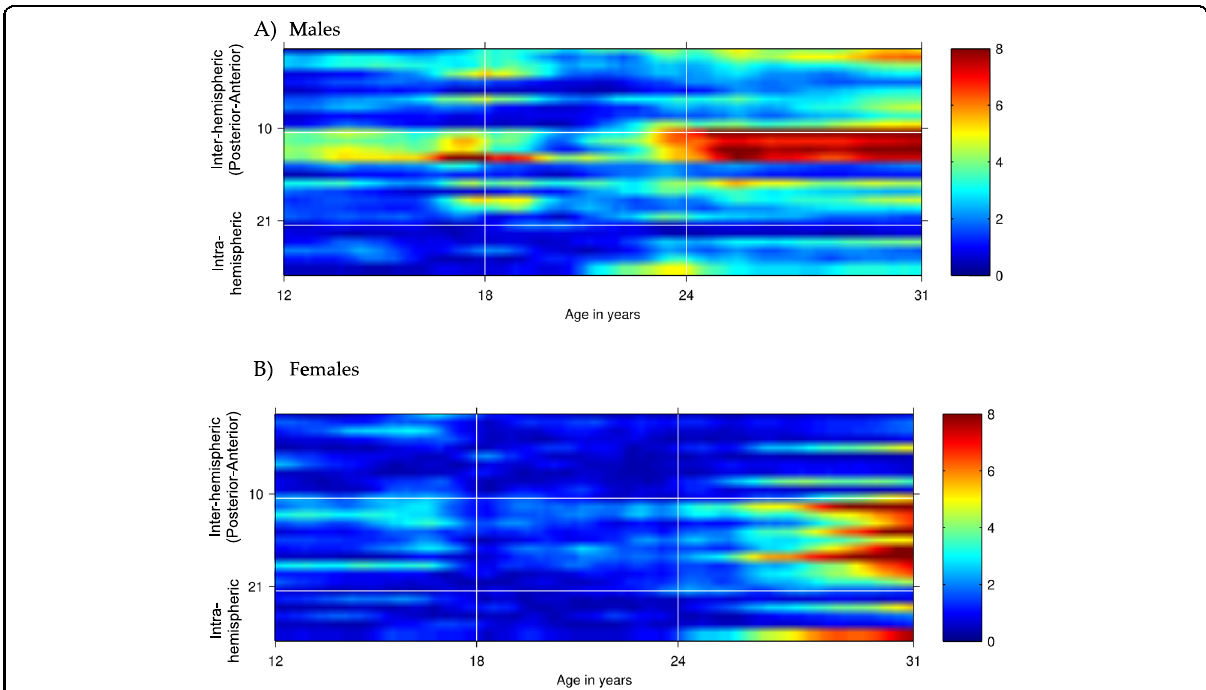
Fig. 4 Association of depression PRS with interhemispheric and intrahemispheric high-alpha EEG coherence networks in males (A) and females (B) from ages 12 – 31. Age is represented on the x -axis and coherences are represented on the y -axis, with numbering 1 – 27 corresponding to coherences between bipolar electrode pairs illustrated in Fig. 1. Regional divisions are marked with horizontal white grid lines: 1 – 10 anterior (frontal-central); 11 – 21 posterior (central-parietal-occipital); 22 – 27 left and right intrahemispheric. Color values in the main panels indicate levels of signi fi cance ( p -values on a negative log 10 scale) as indicated by the color bars on the